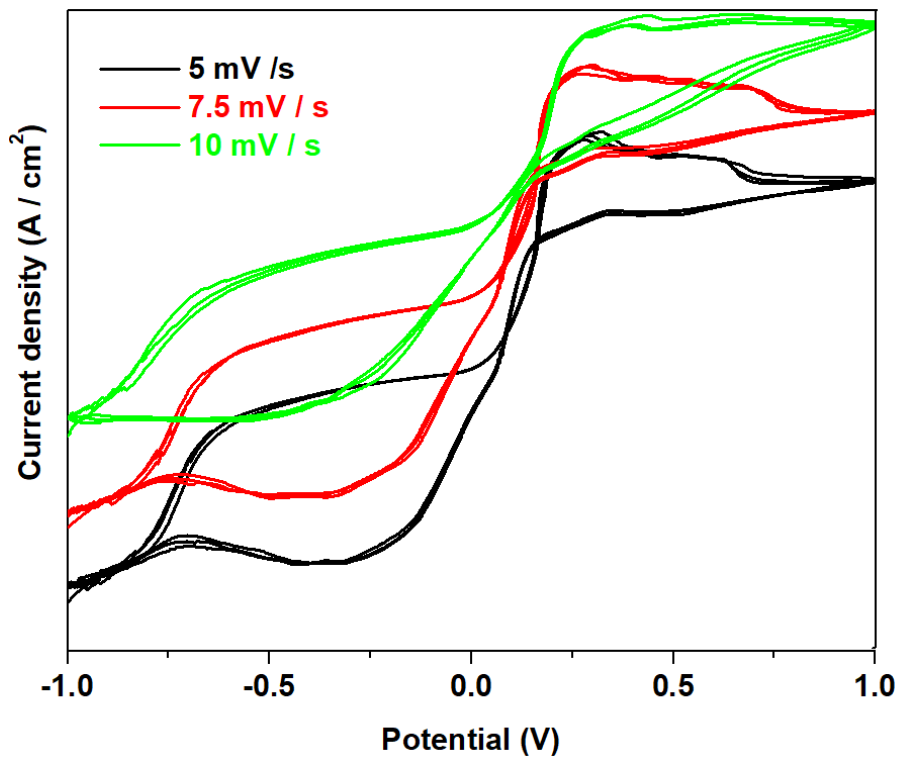
Figure 8. Cyclic voltammograms of the sample with 70 mol% NaH 2 PO 4 scannedafter three cycles at different scan rates (from 1 mV/s to 10 mV/s).